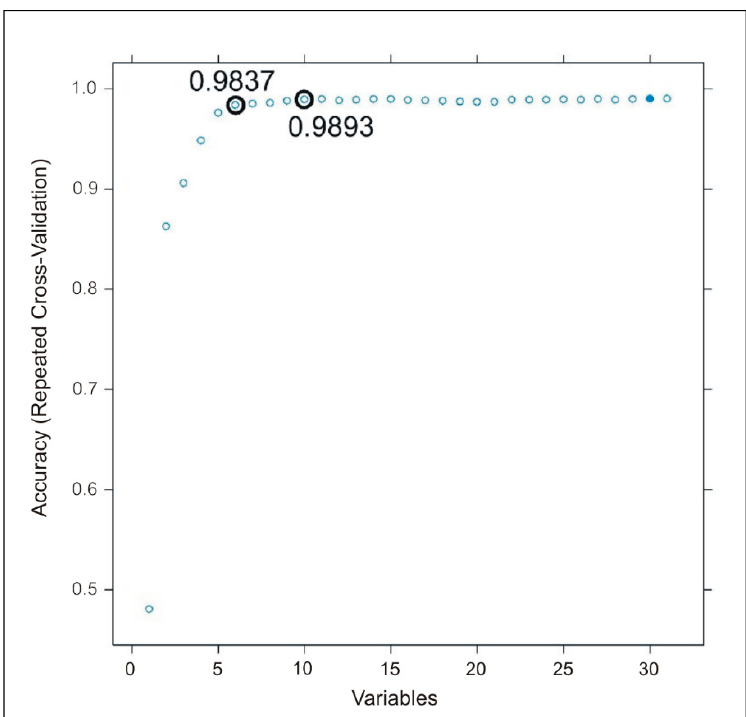
Figure 4. Improvement of overall classification accuracy (OA) by the number of variables. Variables are ranked based on recursive feature elimination determined by 10-fold repeated cross-validation in 3 repetitions ( : selected variable sets; •: best OA with 30 variables).